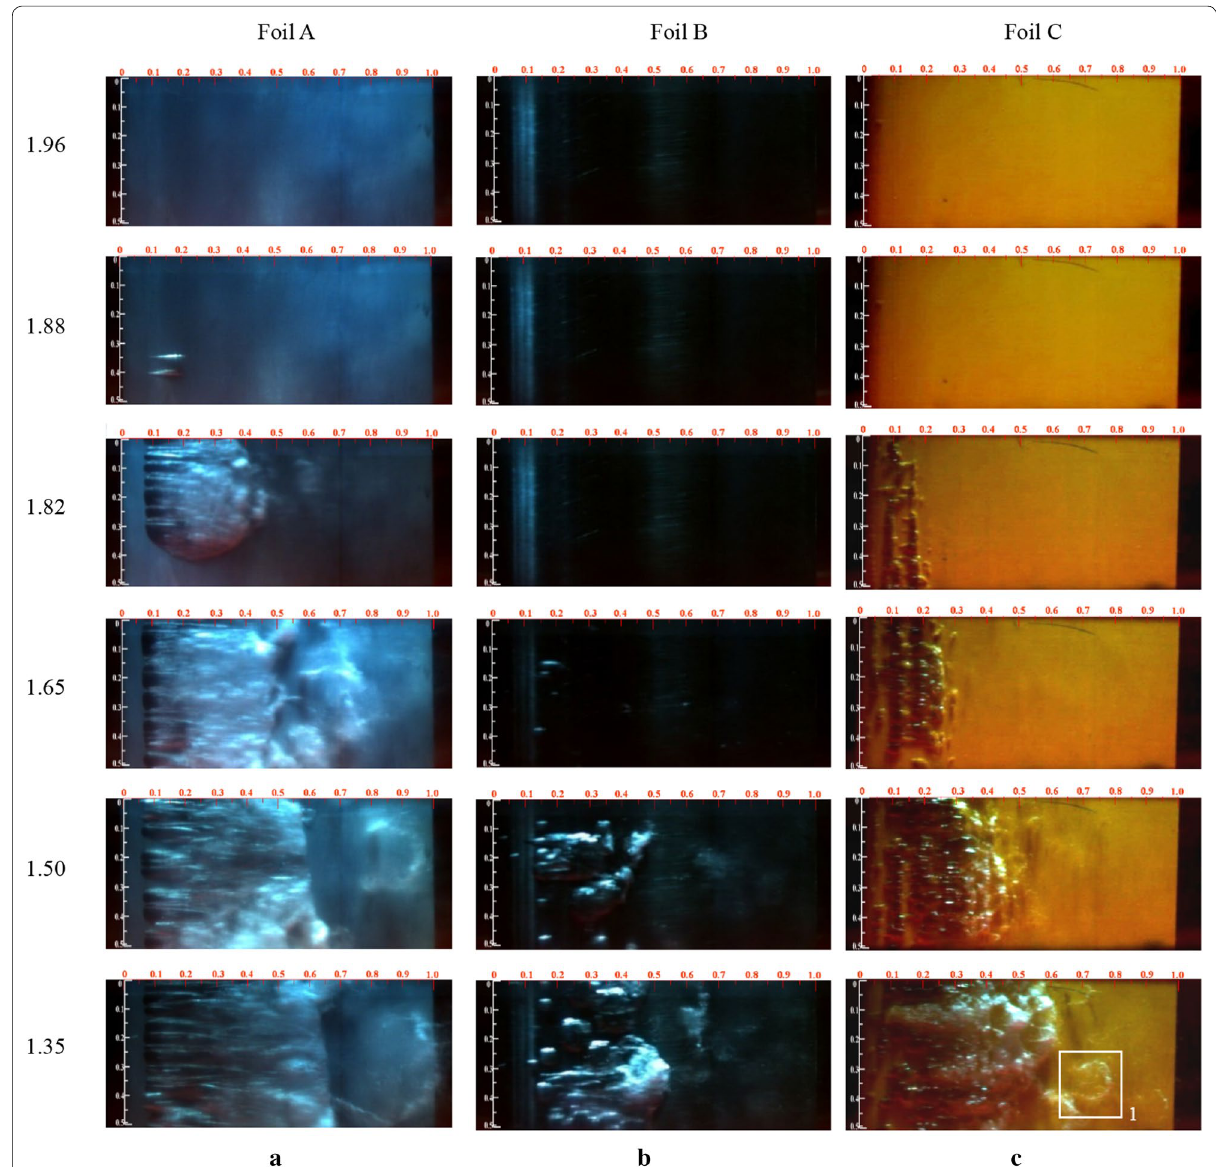
Figure 4 Upward view of inception and sheet cavitation for